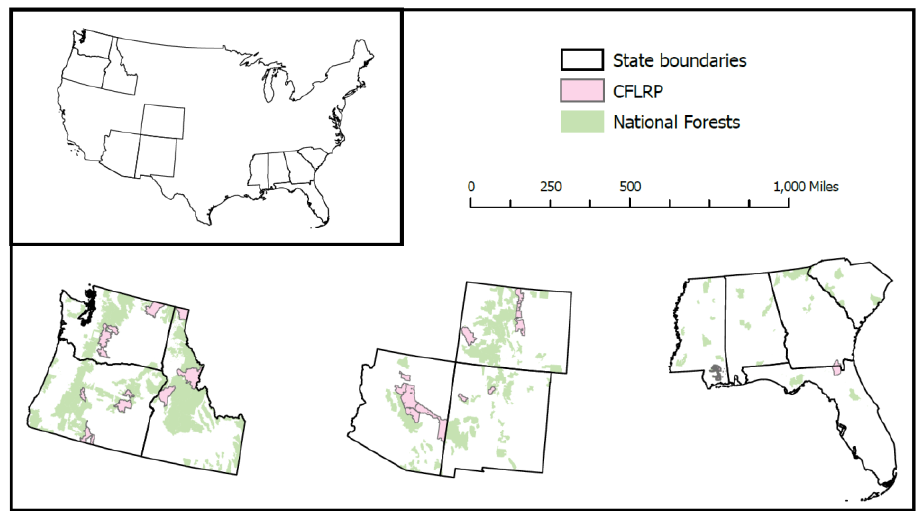
Figure 3. The three U.S. regions detailed in this paper: the Pacific Northwest ( left ), the southwest ( center ), and the southeast ( right ). National Forest land is shown in green shading and Collaborative Forest Restoration Projects are shown as pink polygons.